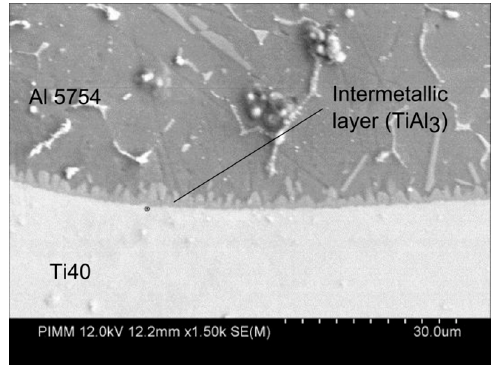
Figure 2. Scanning Electron Microscopy analysis of TiAl 3 serrated intermetallic layer.